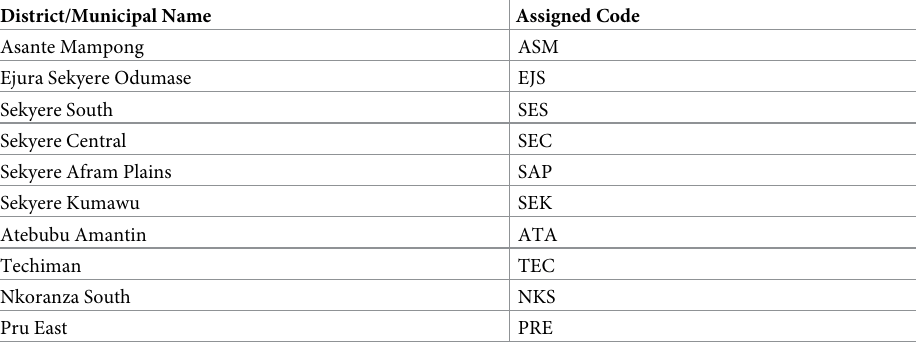
Table 1. District names and codes for samples sent via Zipline.